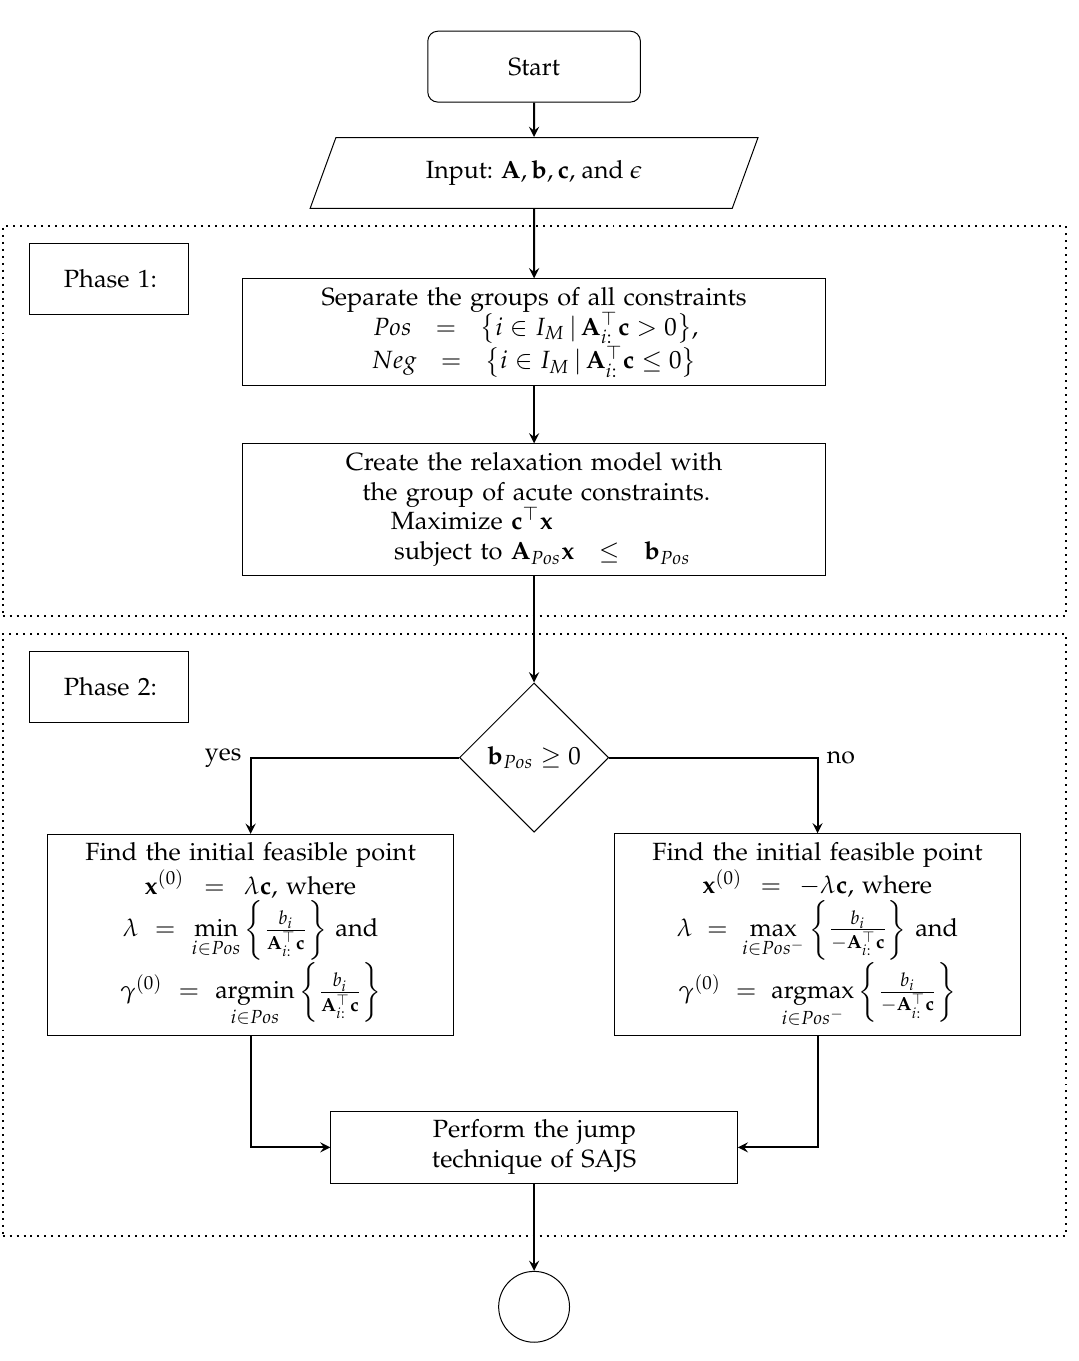
Figure 3. The flowchart of SAJS showing phase 1 and phase